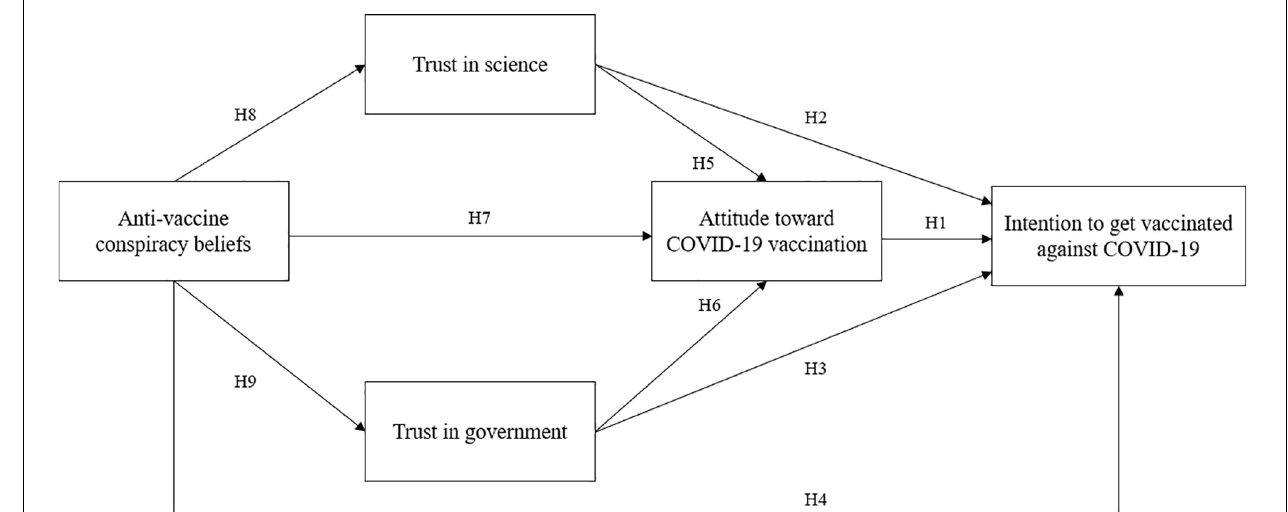
FIGURE 1 | Hypothesized